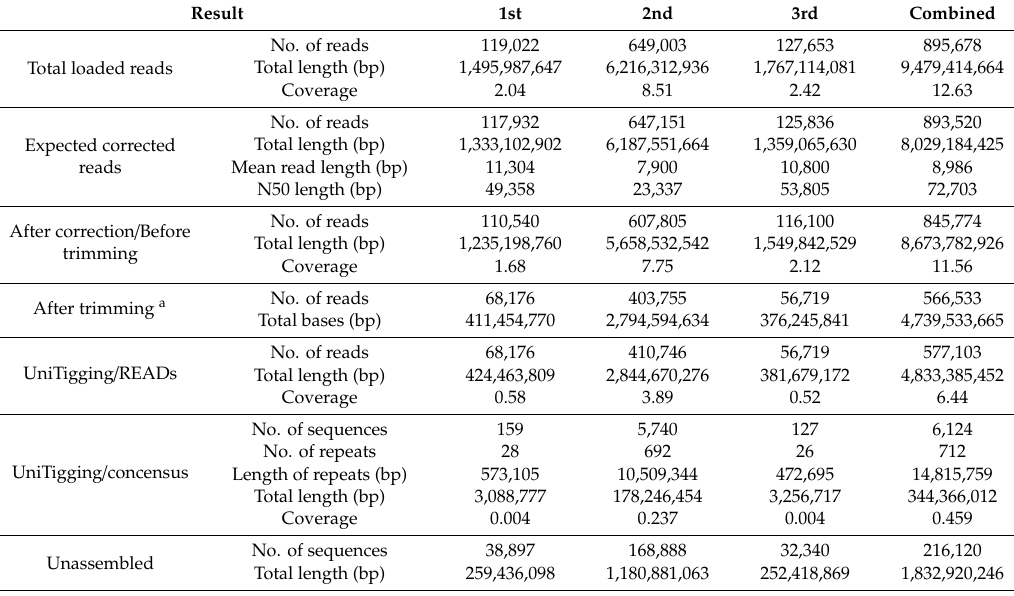
Table 3. Summary of read data for the results of